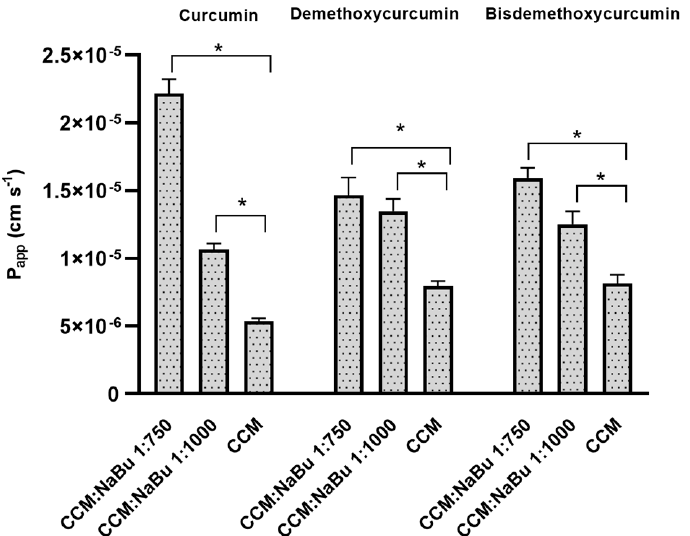
Figure 13. Values of apparent permeability coefficients of curcumin, demethoxycurcumin, and bisdemethoxycurcumin alone and with an addition of NaBu in molar ratio of 1:750 (20 µM CCM:15 mM NaBu) and 1:1000 (10 µM CCM:10 mM NaBu) determined for permeability through nasal cavity. Values are shown as mean ± SEM calculated from three independent experiments. (*) indicates statistically significant differences, p < 0.05.